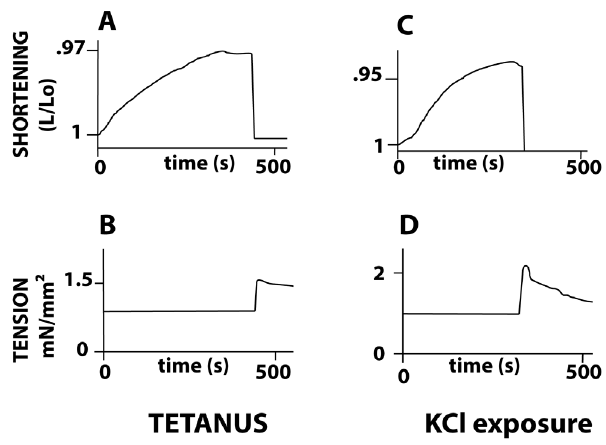
Figure 1. Changes in PSV contractile activity were induced by means of either electrical tetanus (panels A and B) or KCl exposure (panels C and D). Panels A and C: PSV shortening length versus time curves; Panels B and D: PSV tension versus time curves. Just after the onset of stimulus, a slow isotonic shortening at basal tone began, and reached a plateau. Basal tone was the load imposed to the PSV which induced neither shortening nor lengthening of PSV before both KCl exposure and electrical tetanus. PSV was then abruptly submitted to isometric conditions. After a brief overshoot due to the load clamp, PSV tension progressively decreased towards a plateau representing the total isometric tension.